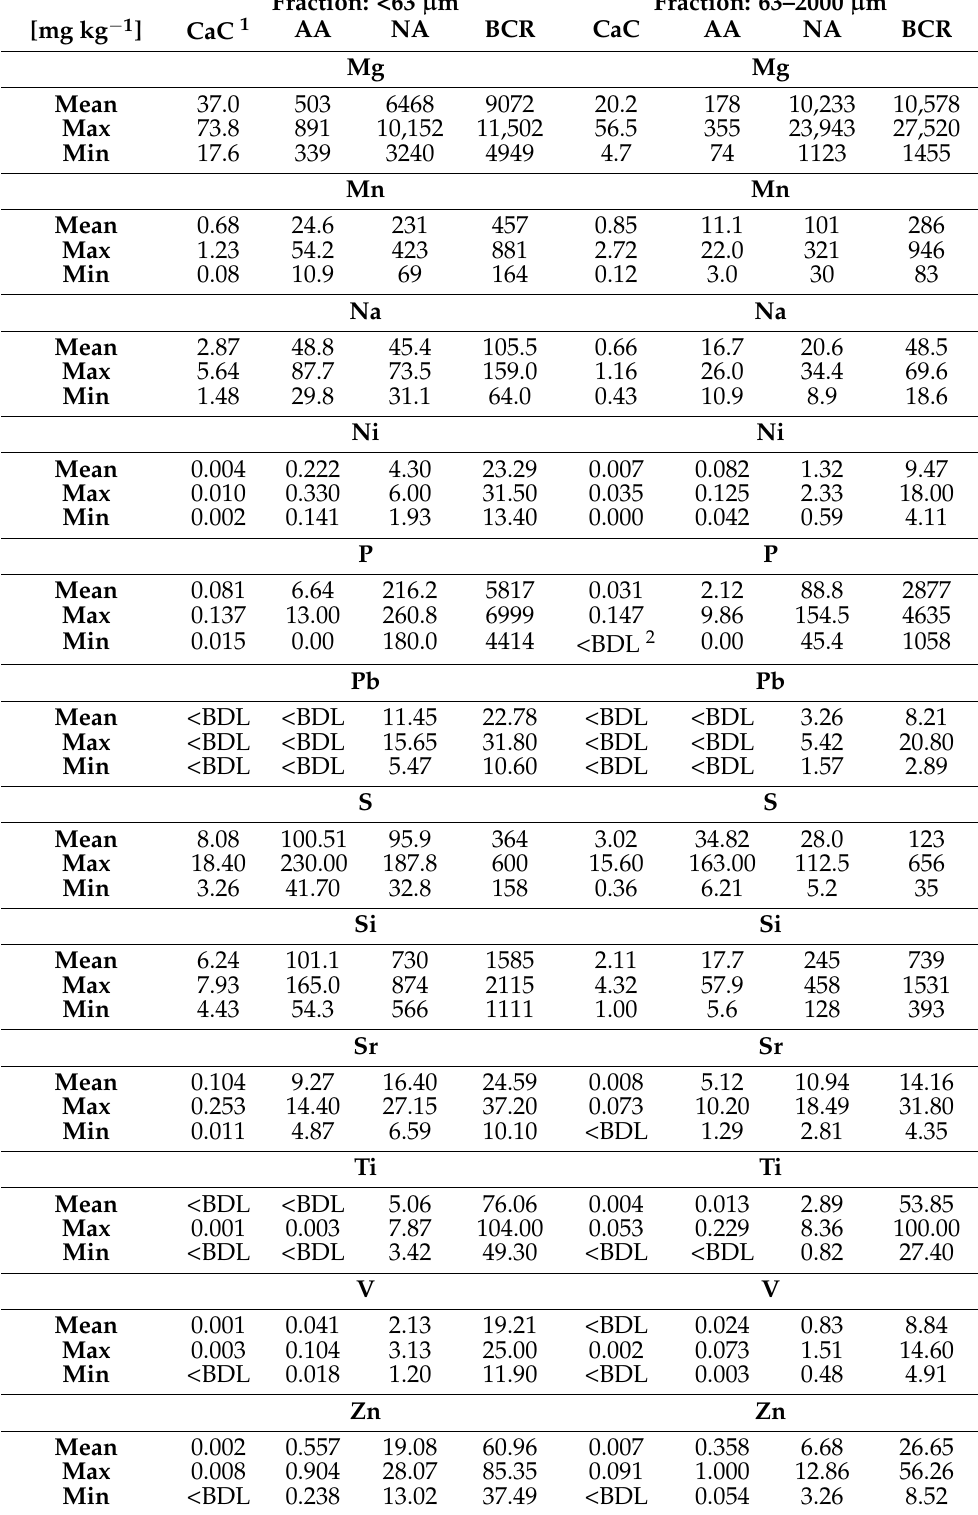
Table 4. Statistical analysis of elements’ contents (Mg, Mn, Na, Ni, P, Pb, S, Si, Sr, Ti, V, and